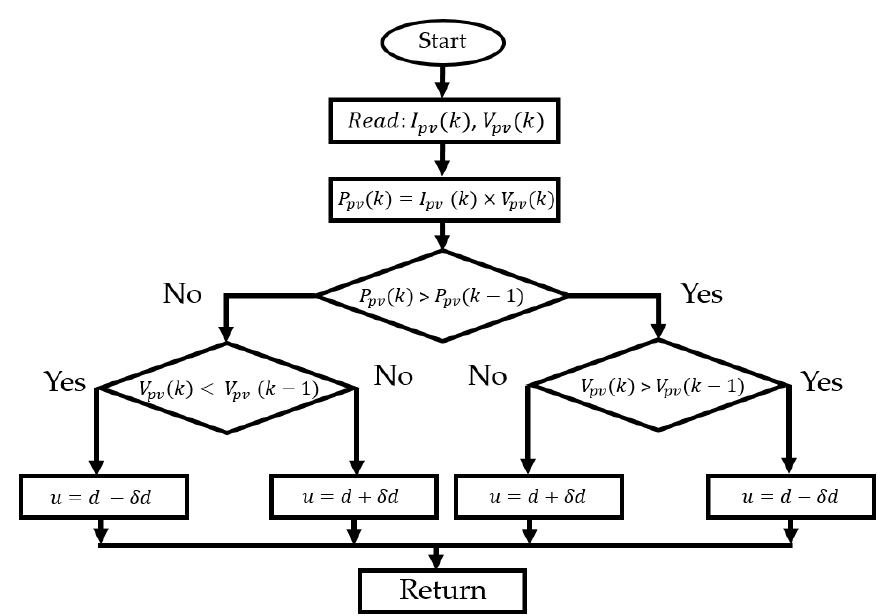
Figure 4. Flowchart of P&O